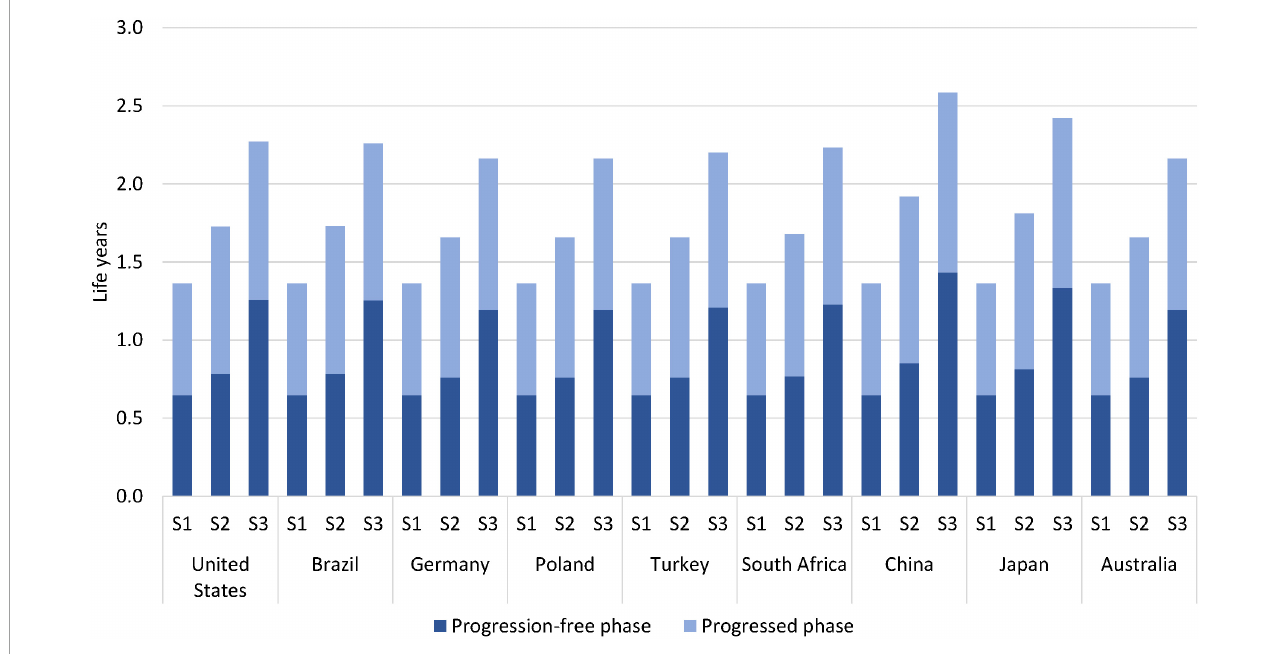
FIGURE2 Estimated life years per patient by testing scenario over a 5-year horizon. S1 = no testing, S2 = sequential testing, S3 = multigene